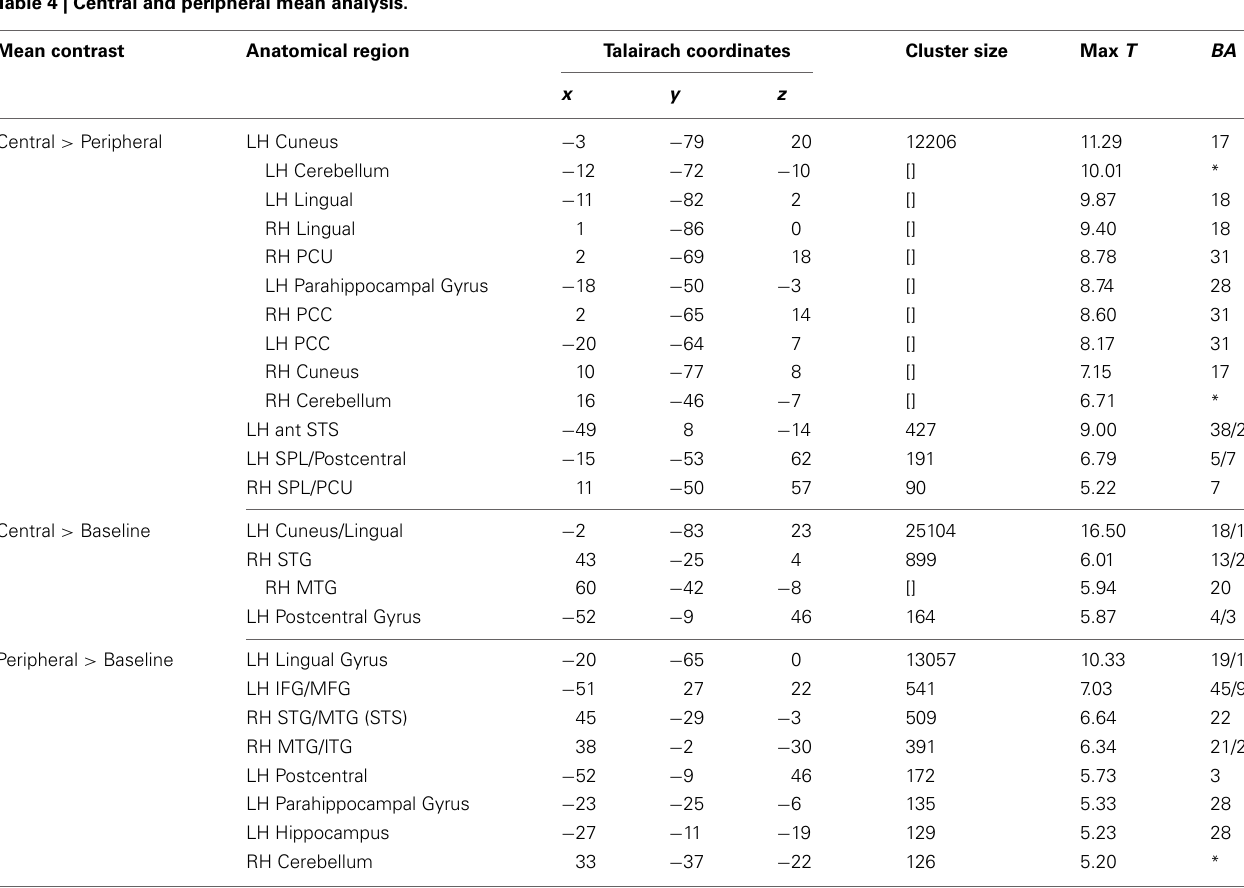
Table 4 | Central and peripheral mean